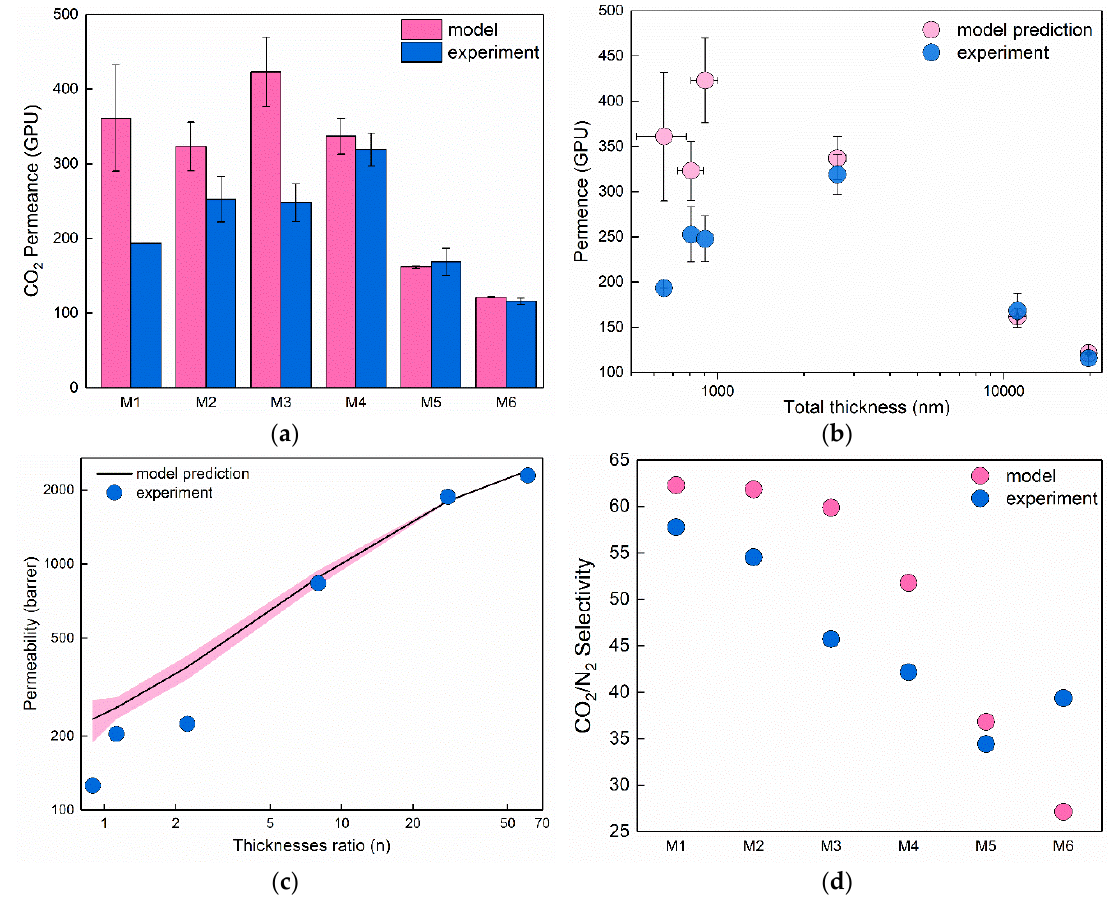
Figure 7. Comparison of the experimentally measured membrane performance with predictions calculated by resistance model: ( a ) CO 2 permeance of fabricated membranes M1–M6; ( b ) CO 2 permeance as a function of total membrane thickness; ( c ) CO 2 permeability dependence on thickness ratio n (pink shading shows 95% confidence interval of prediction considering the error of thickness measurement); ( d ) CO 2 /N 2 selectivity of fabricated membranes M1–M6.